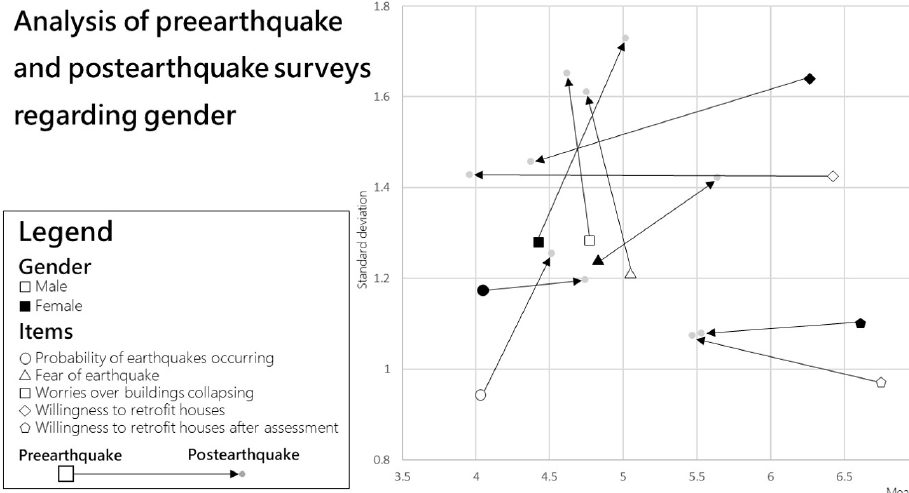
Figure 3. Comparative analysis of the pre- and postearthquake surveys regarding